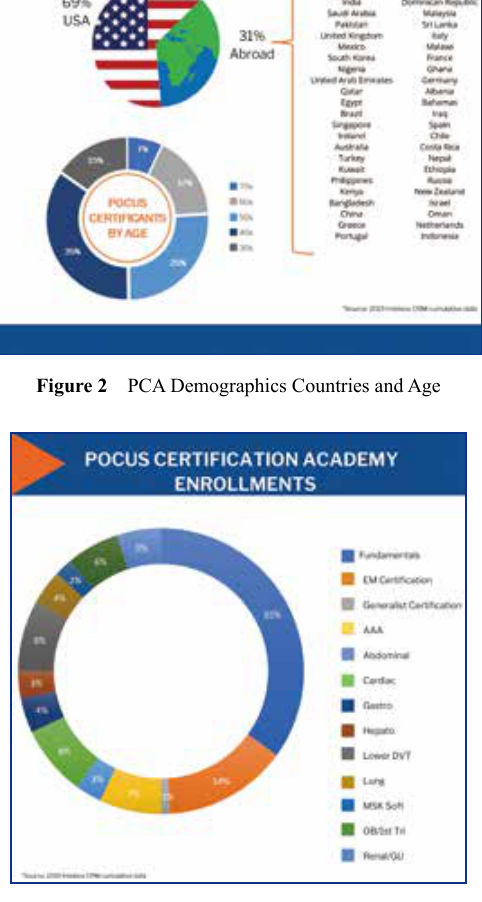
Figure 3 PCA Demographics user type Figure 4 PCA enrollments by certificate